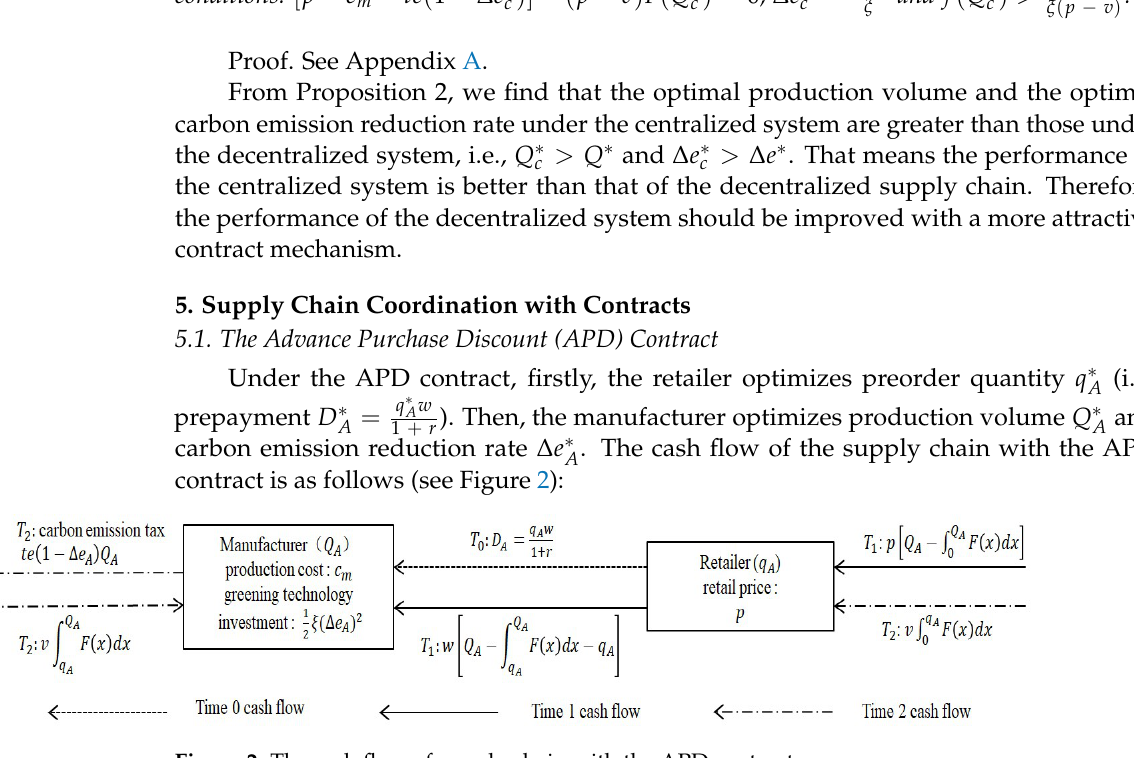
Figure 2. The cash flow of supply chain with the APD contract.